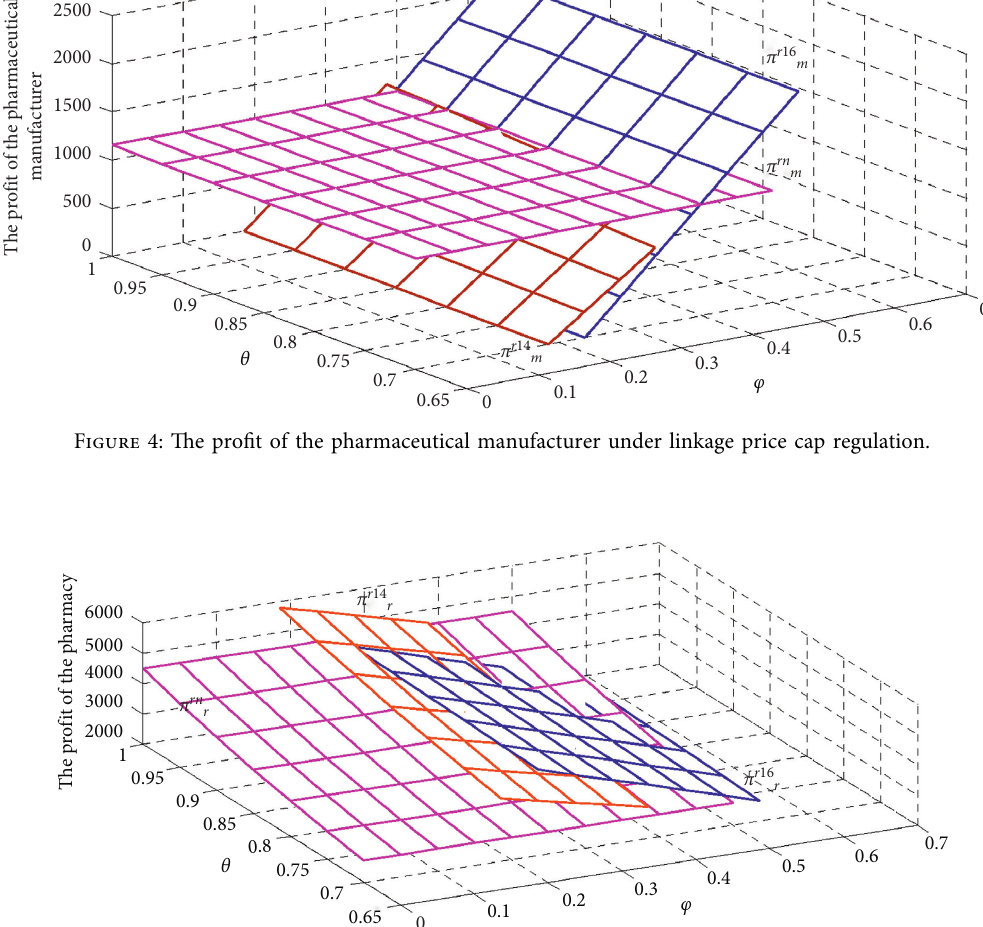
Figure 5: The profit of the pharmacy under linkage price cap regulation.